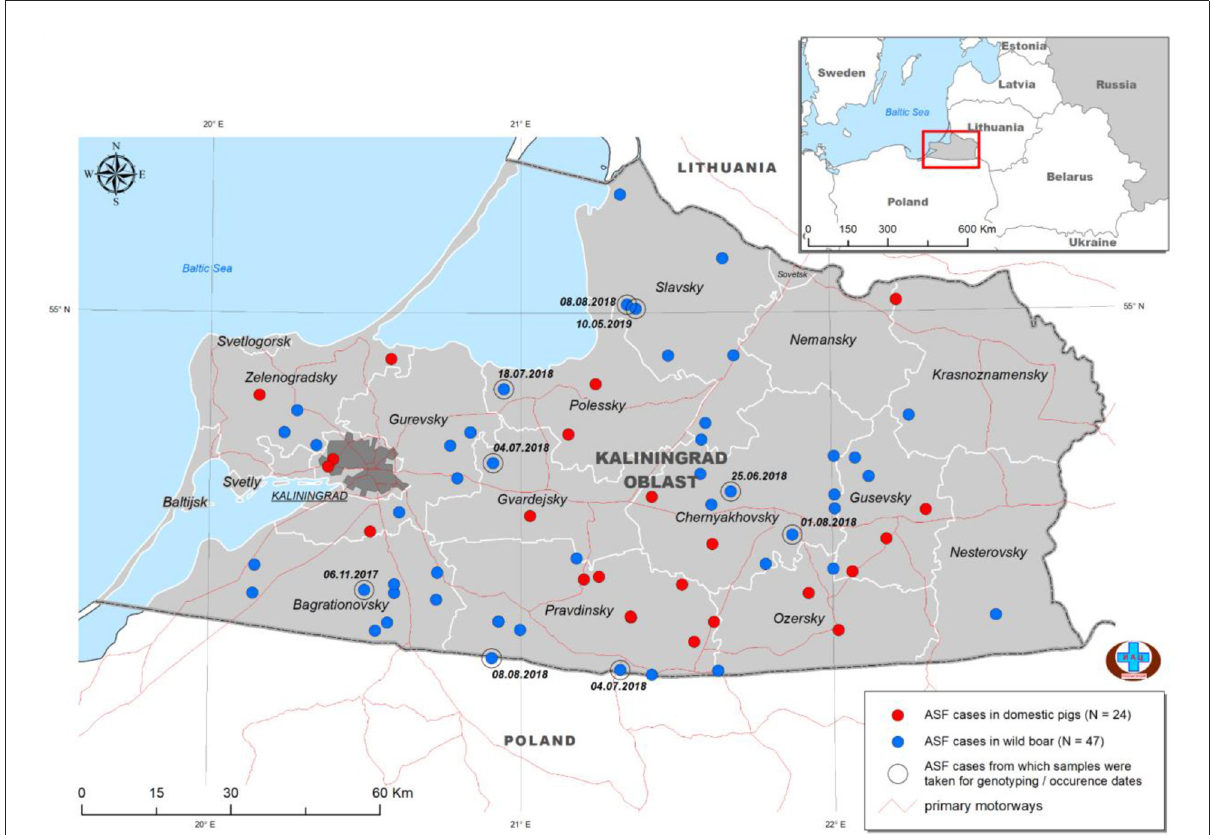
FIGURE1 Distribution of ASFV outbreaks and cases in Kaliningrad between 2017 and 2019. The ASF-positive outbreaks from domestic pigs ( n = 24) are indicated by red dots, whilst those from wild boars ( n = 47) are indicated by blue dots. The nine isolates used in this study are highlighted by a second circle and include the date of notification (data from official OIE site as of